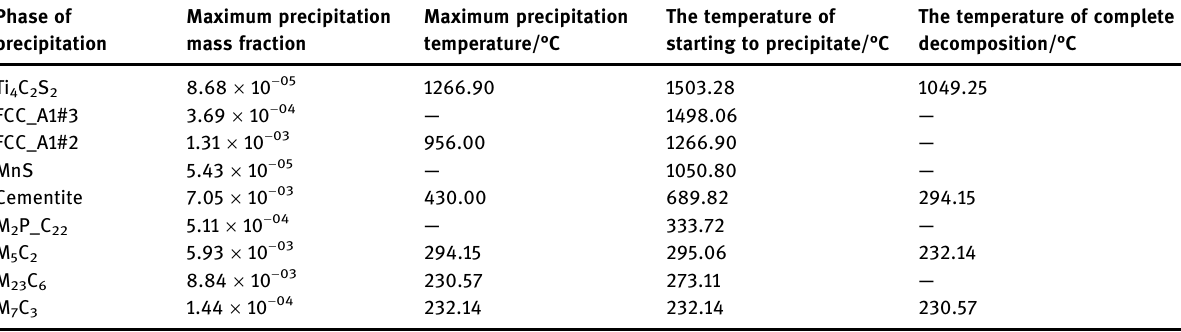
Table 2: The results of equilibrium precipitation of the second - phase particles in experimental steel Phase of Maximum precipitation precipitation